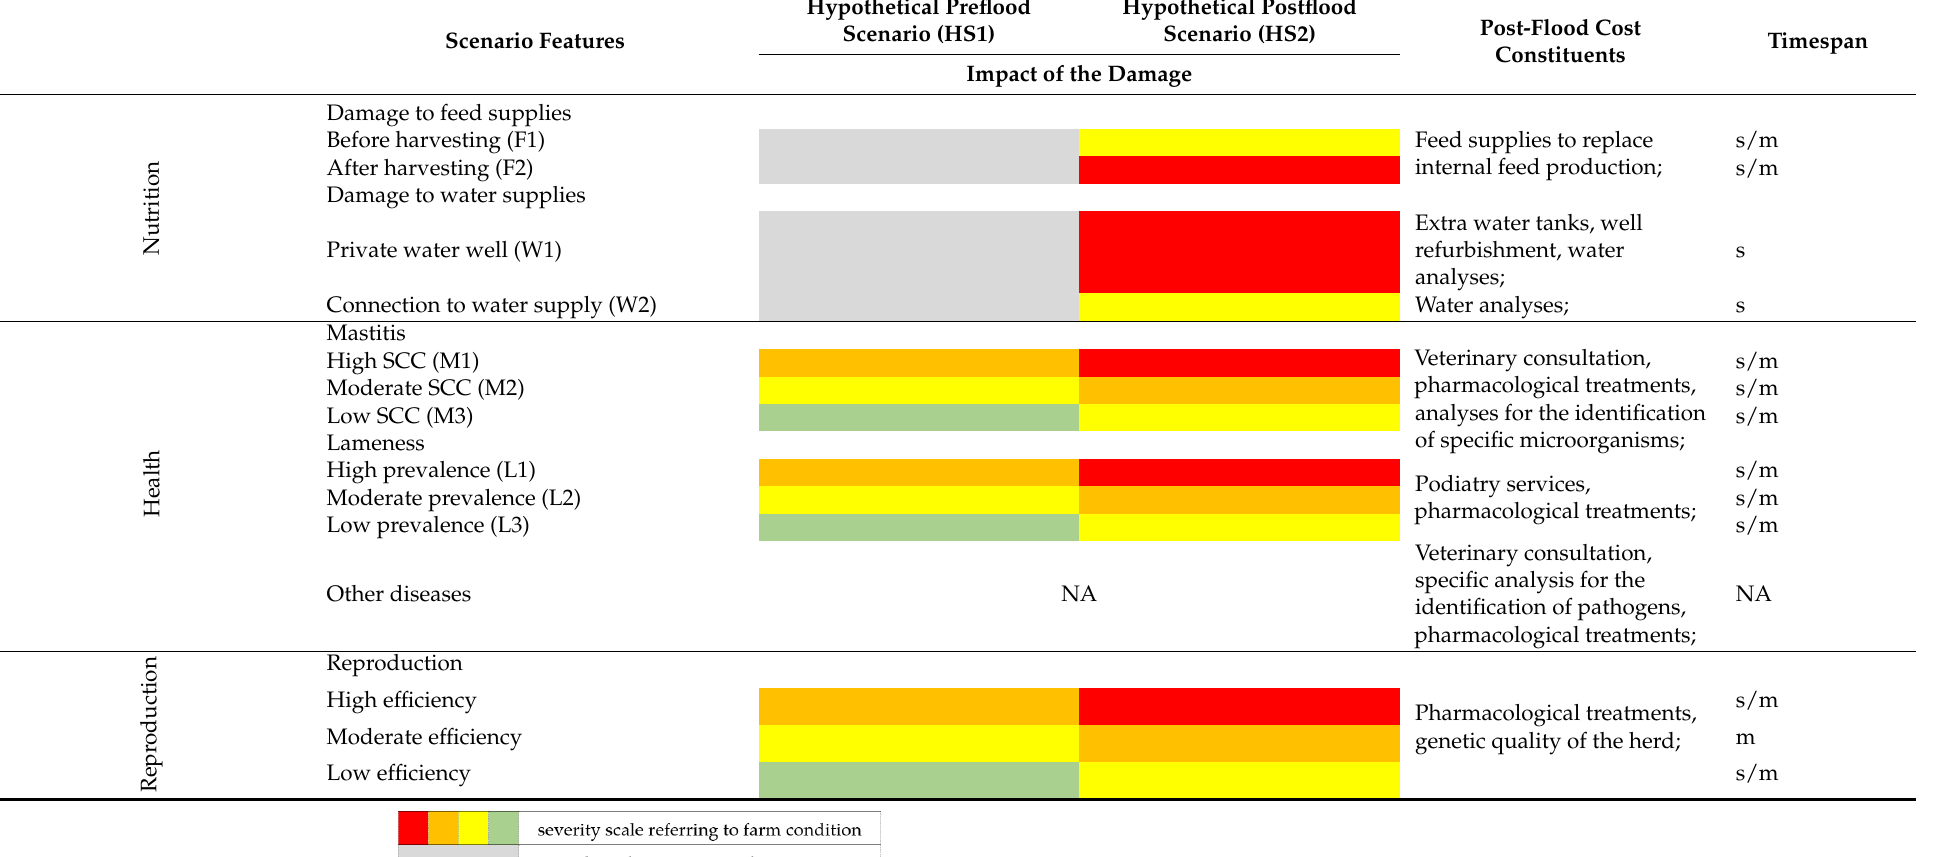
Table 2. Overview of the